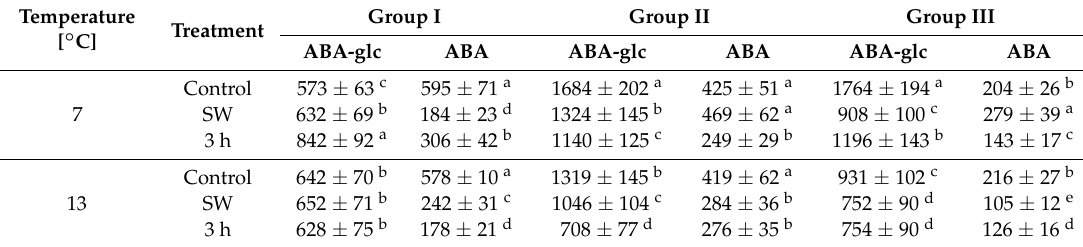
Table 5. Effect of smoke water (SW) and 3-h hydropriming (3 h) on conjugated (ABA-glc) and free abscisic acid (ABA) content [fmol g − 1 of DW] in the seeds of Lupinus angustifolius lines/cultivars germinating at low (7 ◦ C) and control (13 ◦ C) temperature categorized into three groups: I, weakly germinating; II, well germinating; III, very well germinating. Control – non-stimulated seeds.